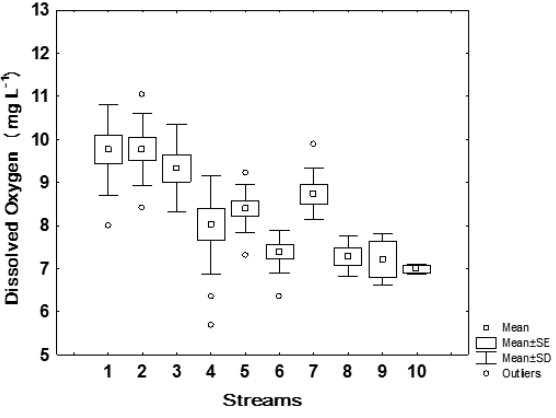
in disturbed watersheds it ranged from 0.92 to 1.21 µM. The same pattern of concentration was found for NH 4+ , which presented all values above the detection limits